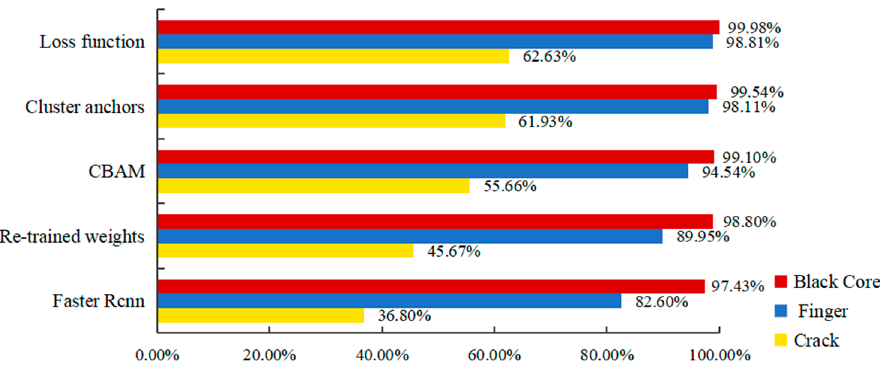
Figure 11. Comparison of AP values of defects with different improvement methods.